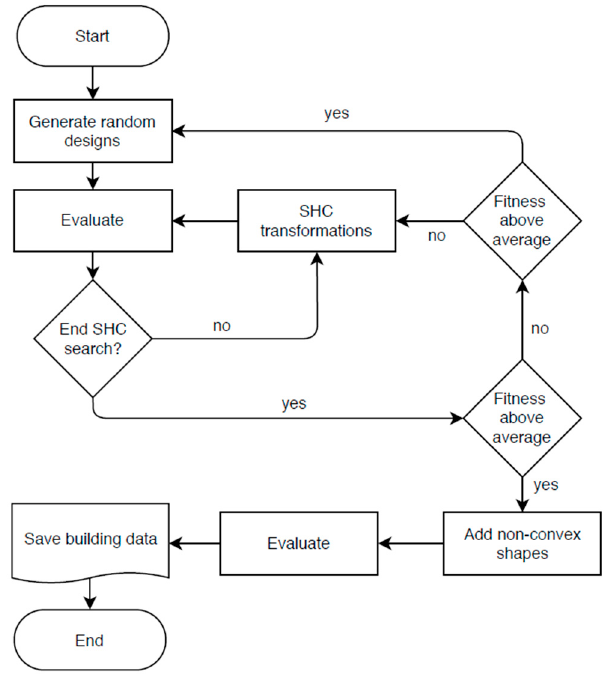
Figure 2. Evolutionary Program for the Space Allocation Problem (EPSAP) algorithm workflow (adapted from ref. [54]).